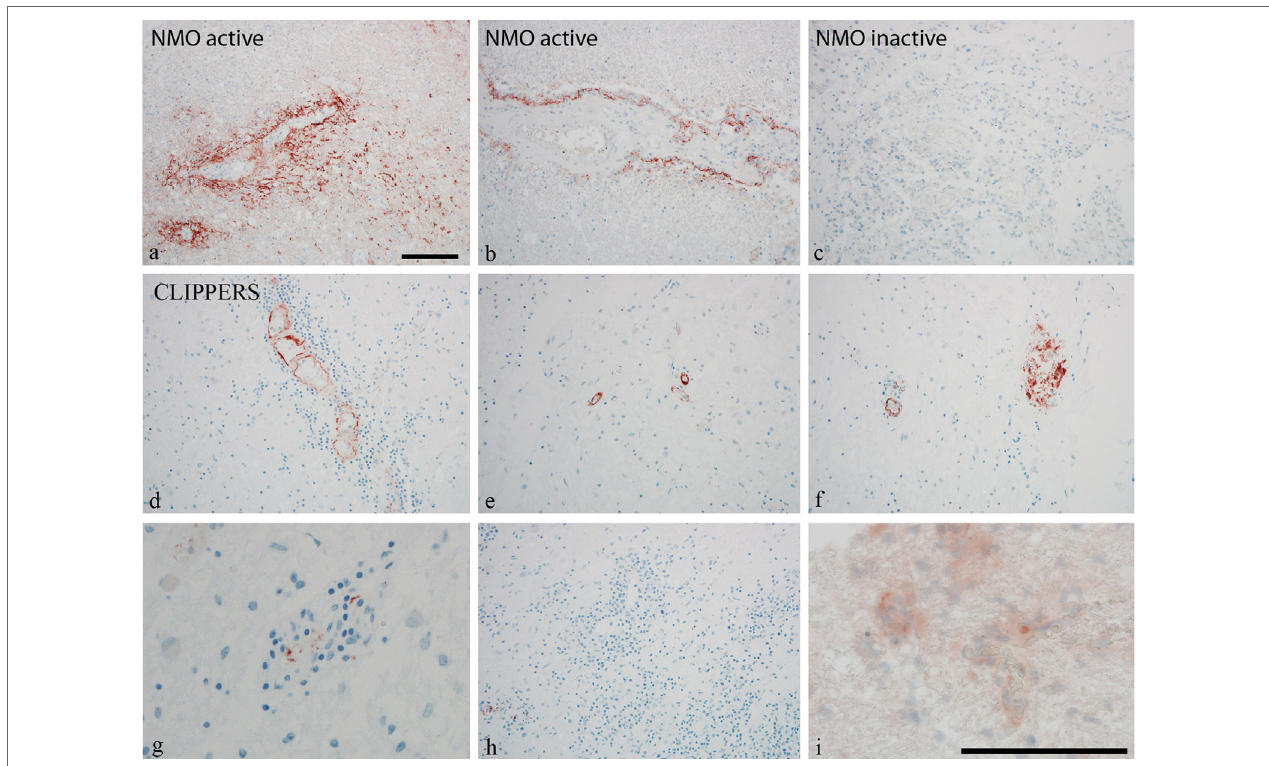
FigUre 3 | Perivascular complement deposition in the brain of patients with chronic lymphocytic inflammation with pontine perivascular enhancement responsive to steroids (CLIPPERS). Autopsy and biopsy samples from patients #1–2 and #5 were analyzed (see also Table 1 ). (a–c) Membrane attack complex (MAC) C9neo (red) reactivity in positive controls from patients with active and inactive neuromyelitis optica spectrum disorder (NMOSD). (D–h) MAC C9neo reactivity in autopsy (patient #5). (i) C9neo reactivity in biopsy specimen (patient #2). Sections were counterstained with toluidine blue. Magnification bars represent 100 μ